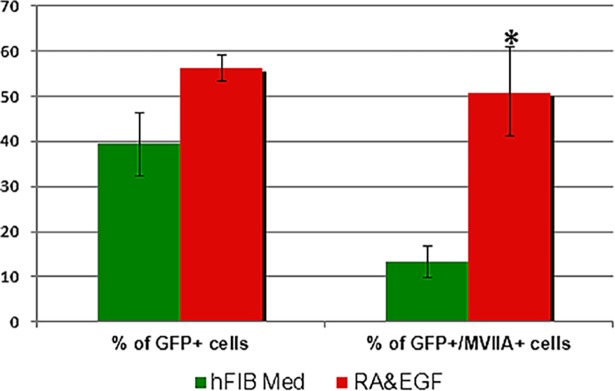
Quantification of the percentage of GFP- and Myosin VIIA colabelled cells.GPA hFIB cultures grown for two weeks in hFIB Med (green), and GPA hFIB cultures grown for two weeks in RA&EGF (red), following transduction. Asterisk: p value<0.005.